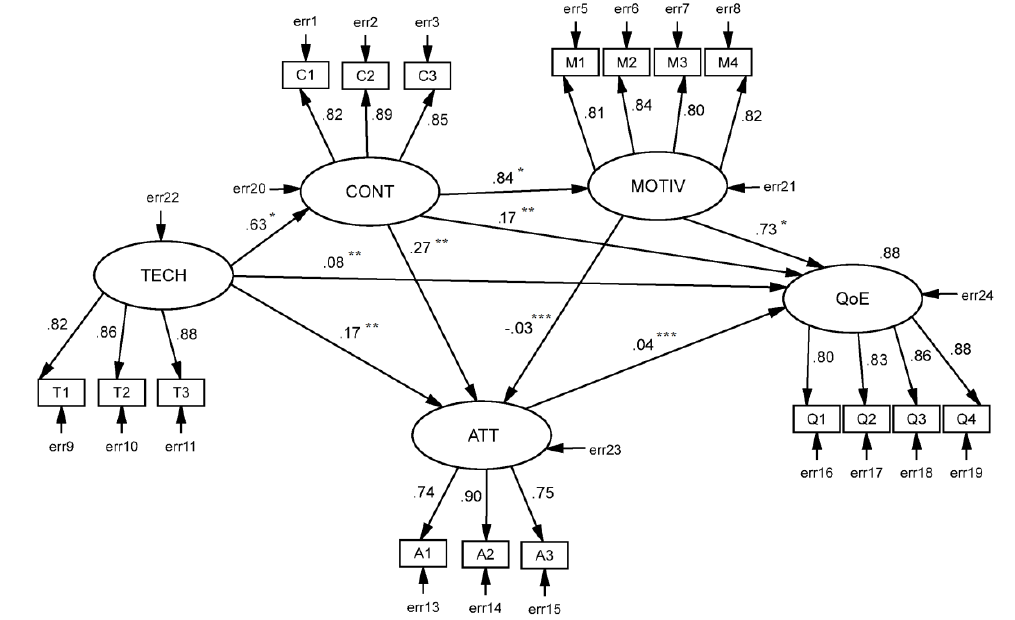
Figure 1. High school students’ QoE prediction model in an asynchronous learning environment (* p < 0.001, ** p < 0.05, *** p > 0.05,